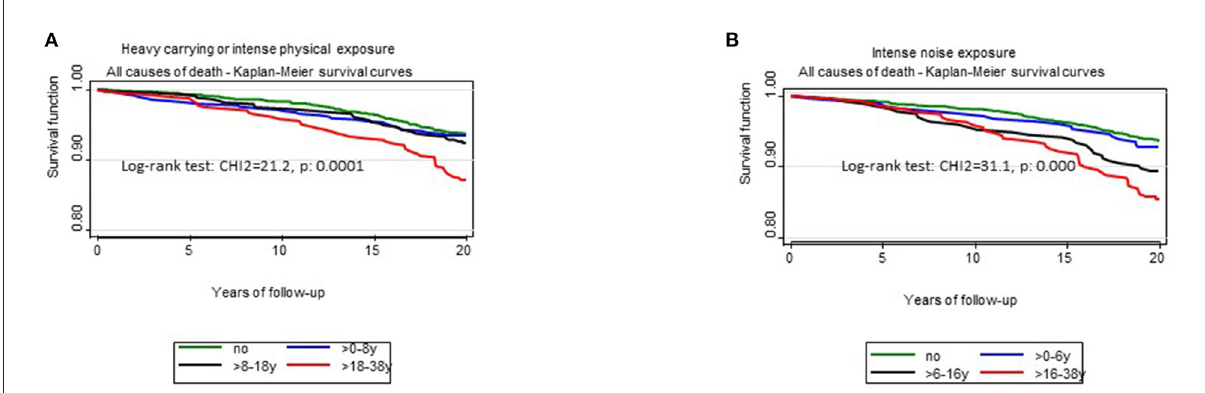
FIGURE1 Kaplan-Meier survival curves for all-cause mortality according to exposure duration of occupational physical constraints. (A) Kaplan–Meier survival curves according to exposure duration to carrying heavy loads or similar intense physical activity at work. (B) Kaplan–Meier survival curves according to exposure duration to intense noise at